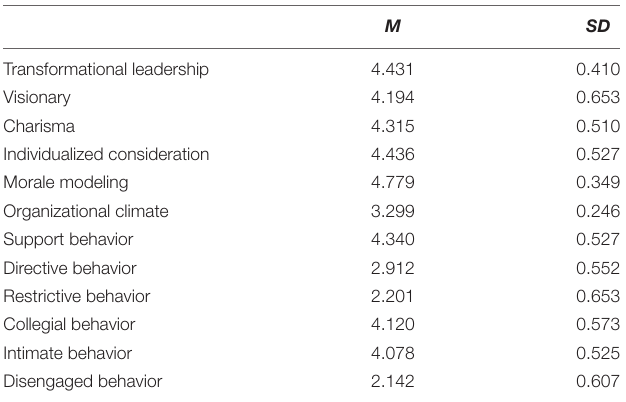
TABLE 1 | Descriptive results of the overall level of transformational leadership and organizational climate in